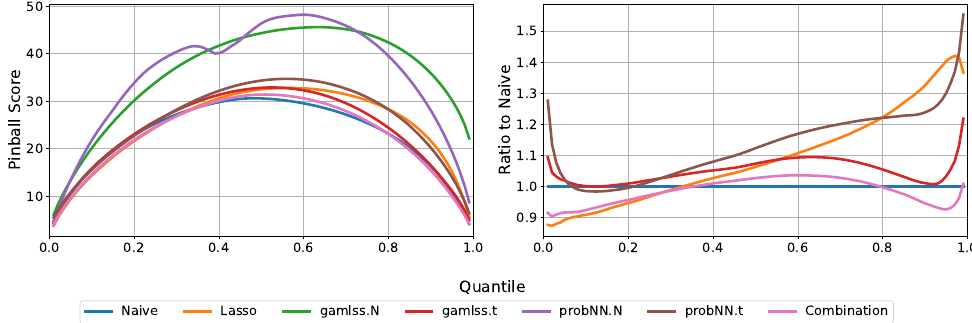
Figure 7. Pinball score ( left ) and its ratio to the naive ( right ) over quantiles τ ∈ r . The right graph shows selected models for better clarity.